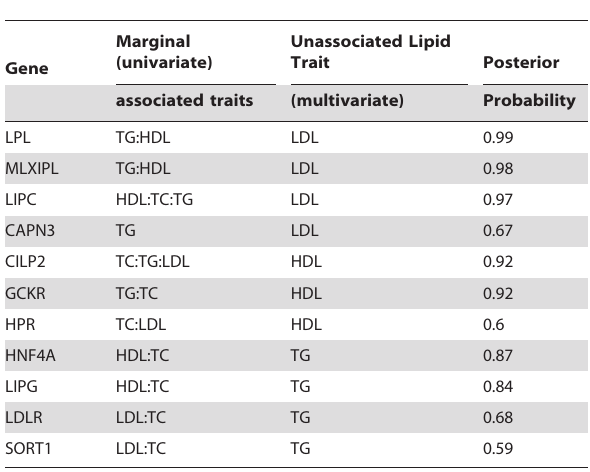
N NROB2 (small heterodimer partner) regulates metabolic pathways, including hepatic bile acid, lipid, and glucose homeostasis [37]. N STAB1 (also known as FEEL-1, and CLEVER-1) codes for the protein stabilin-1 which acts as a scavenger receptor for